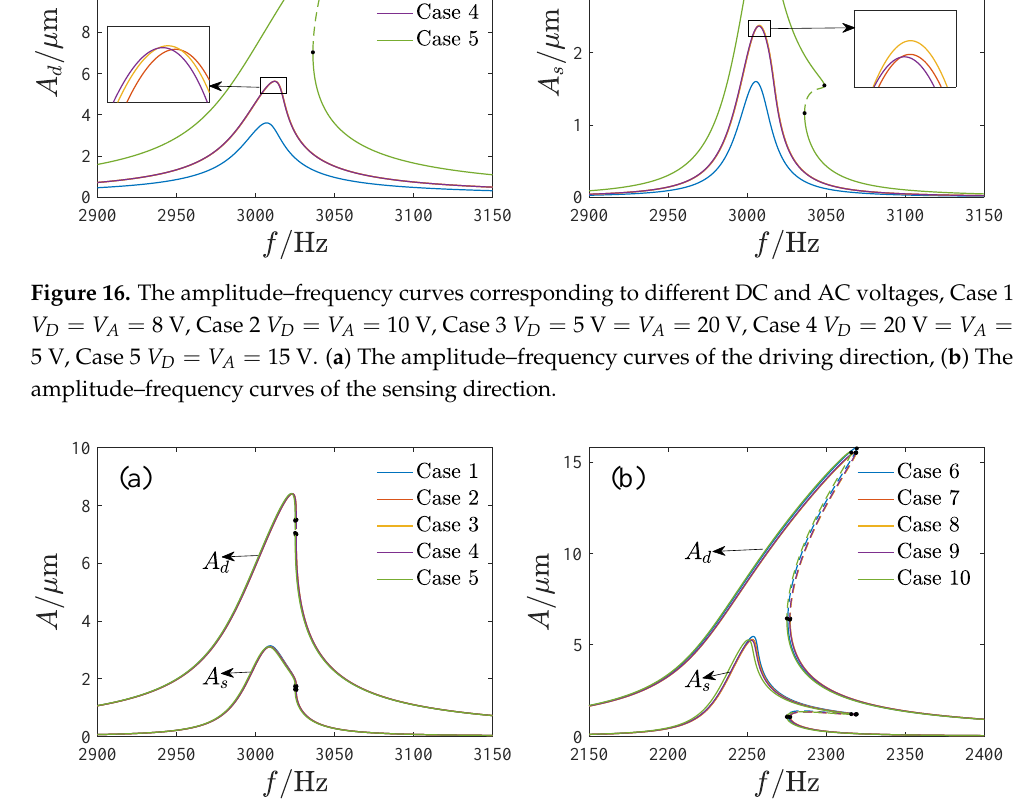
Figure 17. The amplitude–frequency curves corresponding to different values of V D V A and inclina- tion angle, ( a ) V D V A = 150 V 2 , θ = 0, ( b ) V D V A = 250 V 2 , θ = 2